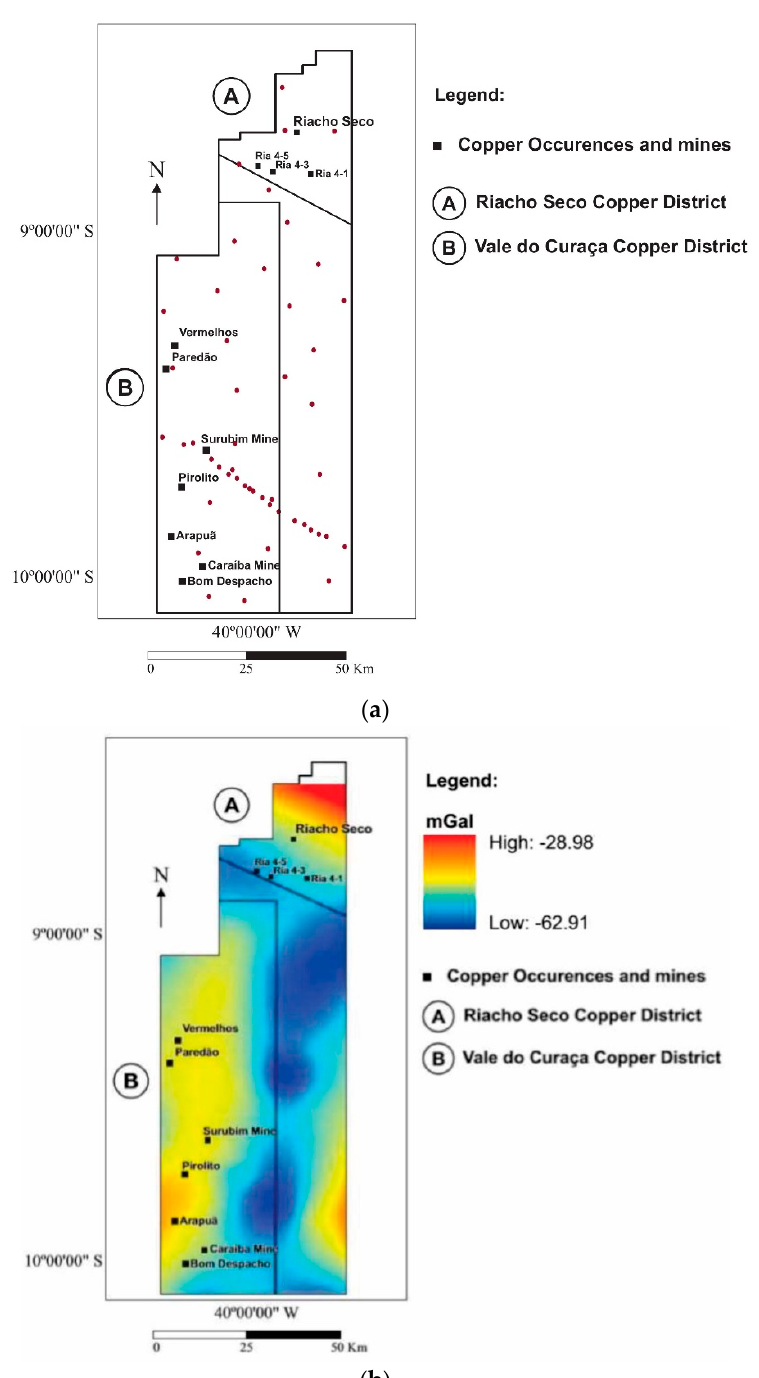
Figure 4. ( a ) Gravity stations and ( b ) Bouguer gravity map for the study area. Major copper occurrences and mines are shown. Block A: Riacho do Pontal district; block B: Vale do Curaça IOCG district.